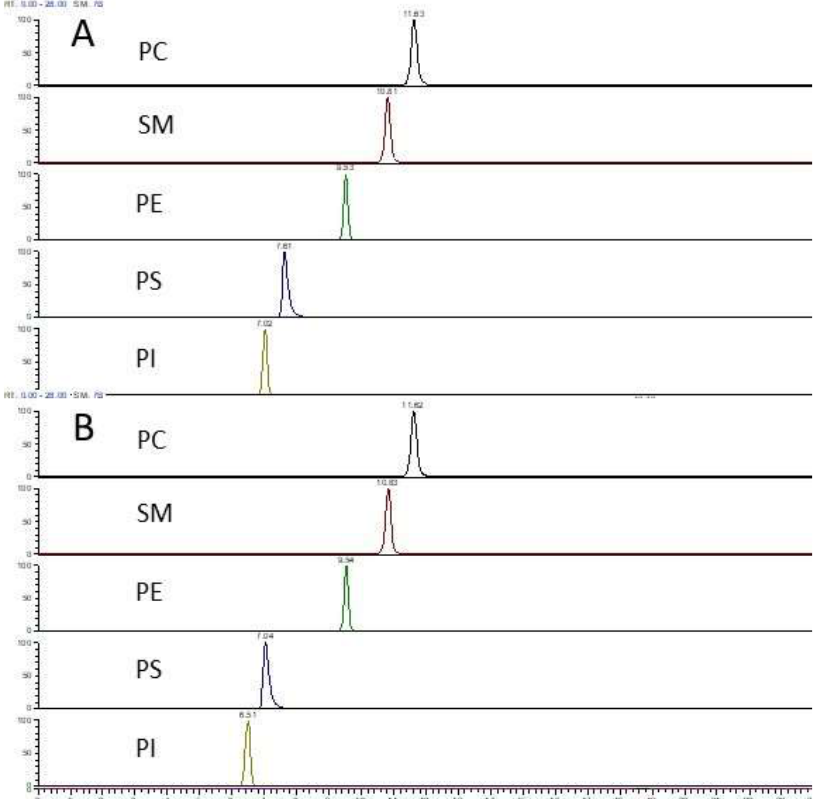
Figure 1. RP-LC-MS profile of phospholipid standards (Mouse Splash Lipidomix standards diluted by 32-fold). The structural information on these deuterated standards is given in Table S1. LC separation was by the Eclipse XDB-C8 column using the multistep gradient elution. Mobile phase additive was 10 mM ammonium formate ( A ) or 10 mM ammonium acetate ( B ) in both binary components.